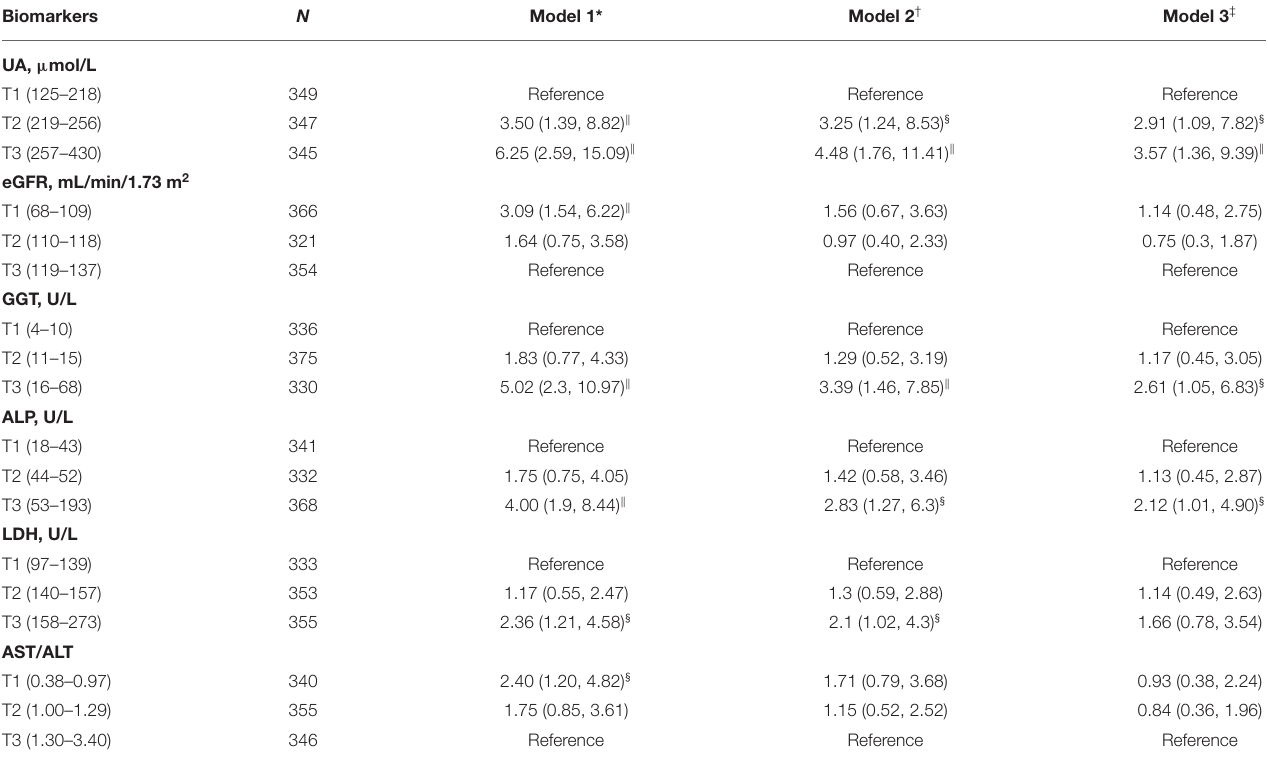
TABLE 4 | Associations of early-pregnancy biomarkers levels with risk of hypertensive disorders of pregnancy.